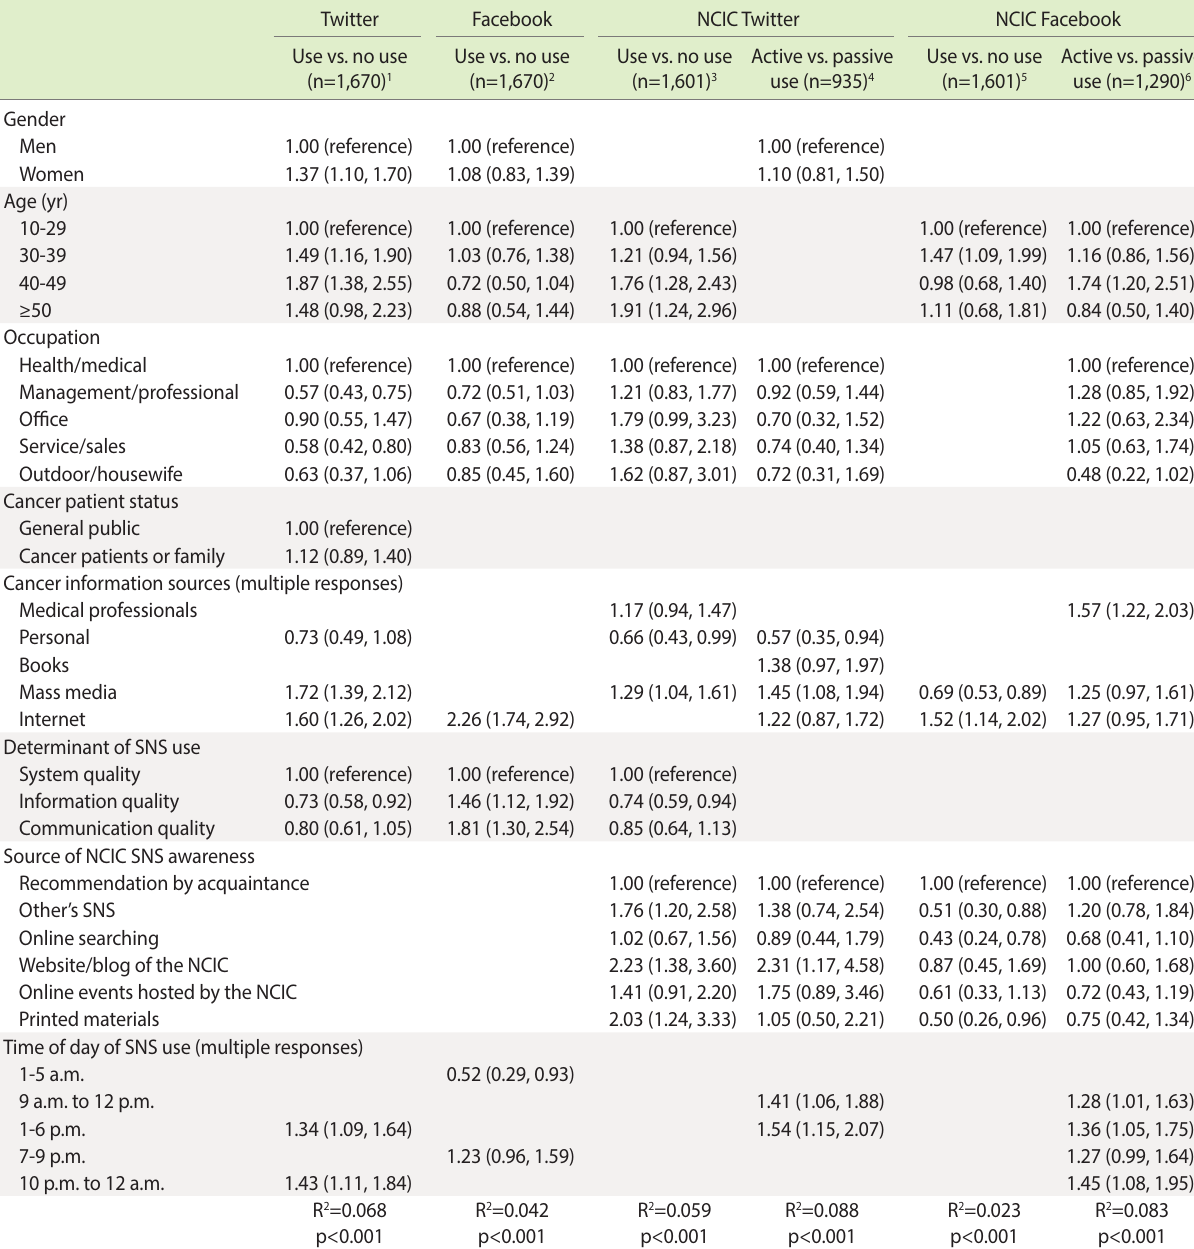
Table 2. Factors associated with SNS